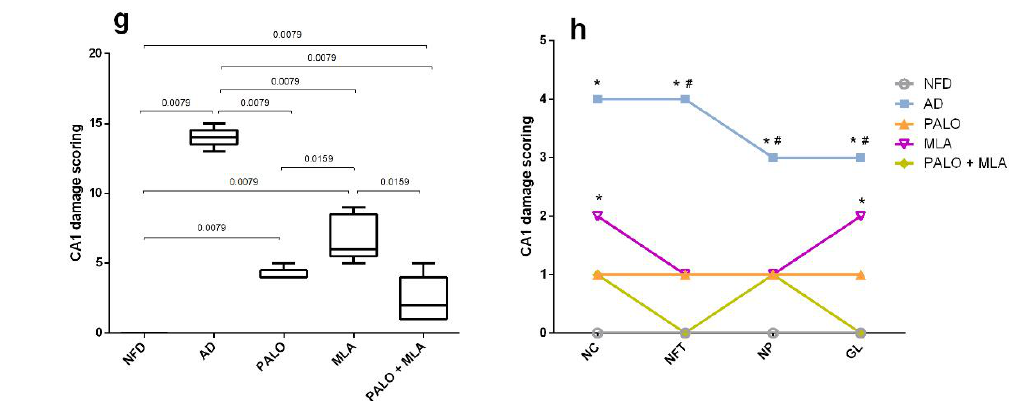
Figure 8. Effects of PALO and/or MLA on hippocampal CA1 histopathological examination in HFFD/LPS-induced AD model. Photomicrograph of H&E stained sections from CA1 region of hippocampus of rats in ( a ) NFD reveals the normal histological architecture of this area with tightly packed normal pyramidal neurons having large vesicular nuclei (NPN). Sections of ( b , c ) AD model shows marked shrunken (SH) and necrosis (NC) of pyramidal neurons, flame-shaped neurofibrillary tangles (NFT) proliferation of glia cells (GL) and neurophagia (NP). Sections of ( d ) PALO, as well as ( e ) MLA treated groups show necrosis (NC) of some neurons and other neurons appeared normal (NPN), while sections of ( f ) PALO + MLA treated group shows restored histologically normal neurons (NPN) with necrosis of sporadic neurons (NC) (Scale bar 20 µm, × 600). Panel ( g ) represents collective CA1 damage scores presented in box and whisker and analyzed using Mann – Whitney test to compare between 2 groups. Panel ( h ) depicts individual CA1 alteration scores expressed as median (max-min) and analyzed using the Kruskal – Wallis test, followed by Dunnett ’ s post hoc test ( p < 0.05), as compared from (*) NFD and (#) PALO + MLA treated group. PALO (0.1 mg·kg −1 ; i.p) and/or MLA (5.6 mg·kg −1 ; i.p) were administered 3 h after LPS injection and for 8 days.